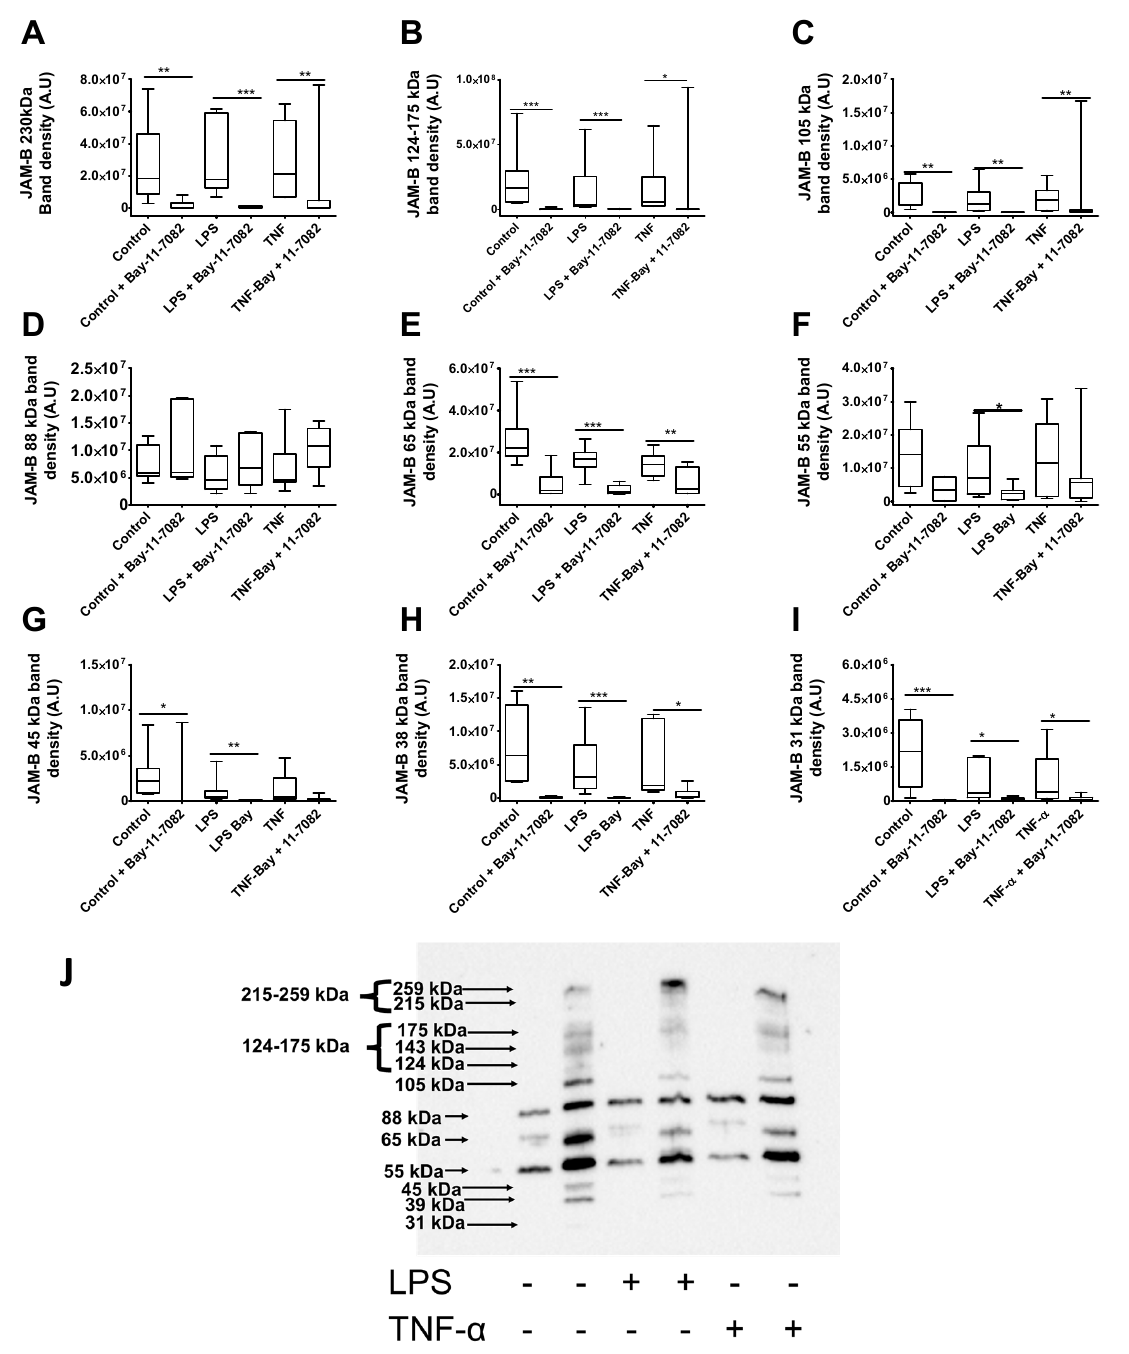
Figure 11. Effects of the Bay-11-7082 inhibitor on the density of JAM-B protein species in THP-1 monocyte whole cell lysates after incubation with and without inflammatory stimuli (relative to total protein on stain-free gel). ( A ) ≥ 230 kDa bands, ( B ) 124–175 kDa bands, ( C ) 105 kDa band, ( D ) 88 kDa band ( E ) 65 kDa band, ( F ) 55 kDa band ( G ) 45 kDa bands, ( H ) 38 kDa band, ( I ) 31 kDa band and ( J ) blot image showing protein band densities in the Bay-11-7082 inhibitor-treated THP-1 whole cell lysates treated with and without inflammatory stimuli. A.U, arbitrary units; * indicates p ≤ 0.05, ** indicates p ≤ 0.01, *** indicates p ≤ 0.001 after Mann–Whitney U test ( n = 7). All bands were normalised to the total protein on the stain-free